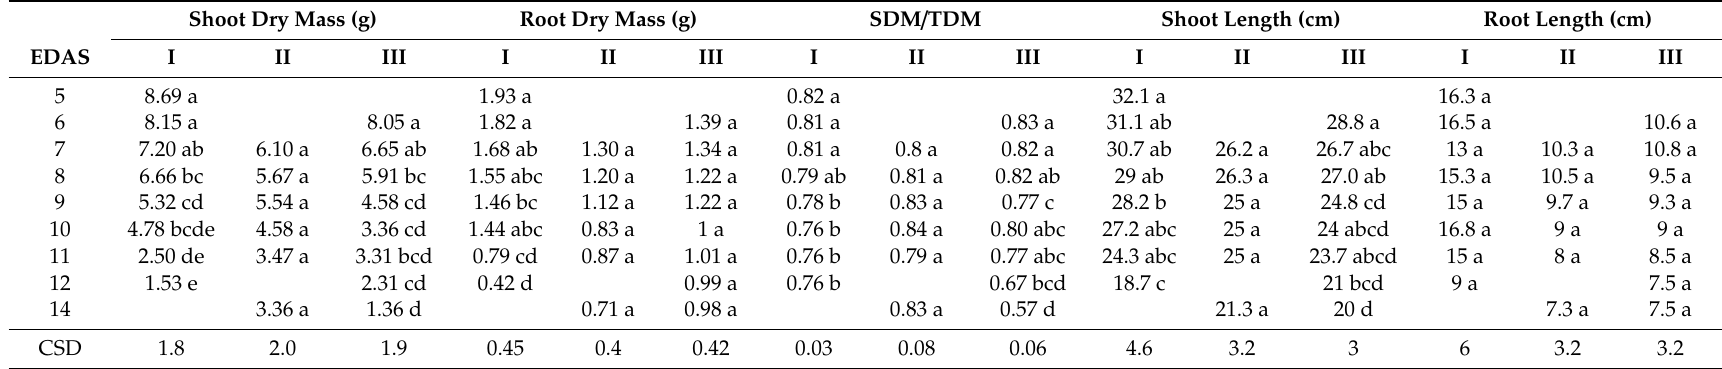
Table 3. Shoot dry mass, root dry mass, dry mass of shoot ratio by total dry mass (SDM / TDM), shoot length, and root length in stage V 4 in soybean plants from distinct emergence days after sowing (EDAS)* at the three sites (I, II, and III). Shoot Dry Mass (g)